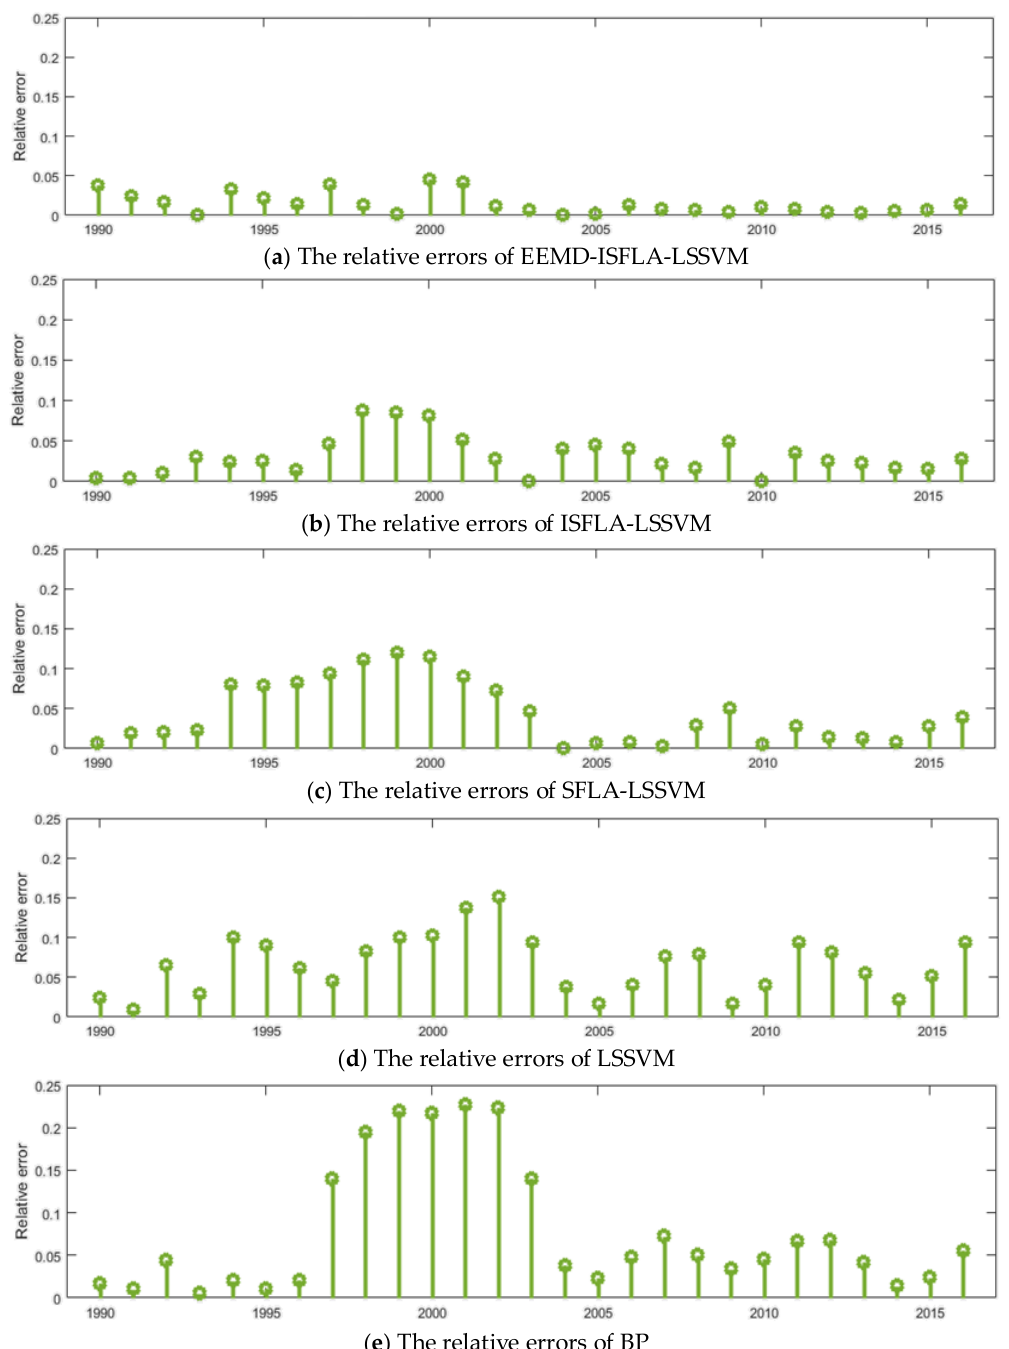
Figure 9. The relative errors of five models: ( a ) EEMD-ISFLA-LSSVM; ( b ) ISFLA-LSSVM; ( c ) SFLA-LSSVM; ( d ) LSSVM; ( e ) BP.